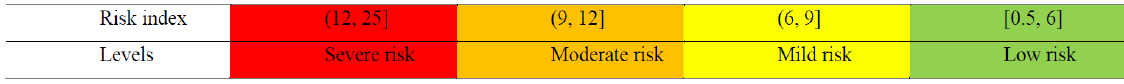
Table 10. Assessment criteria of the risks of sea ice disasters on the oil platforms in the Bohai Sea.